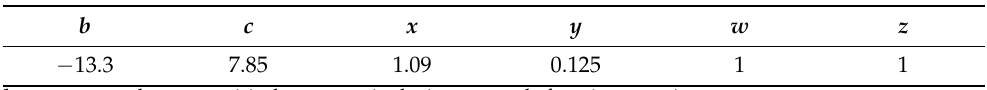
Table 2. Values of parameters in the impact angle